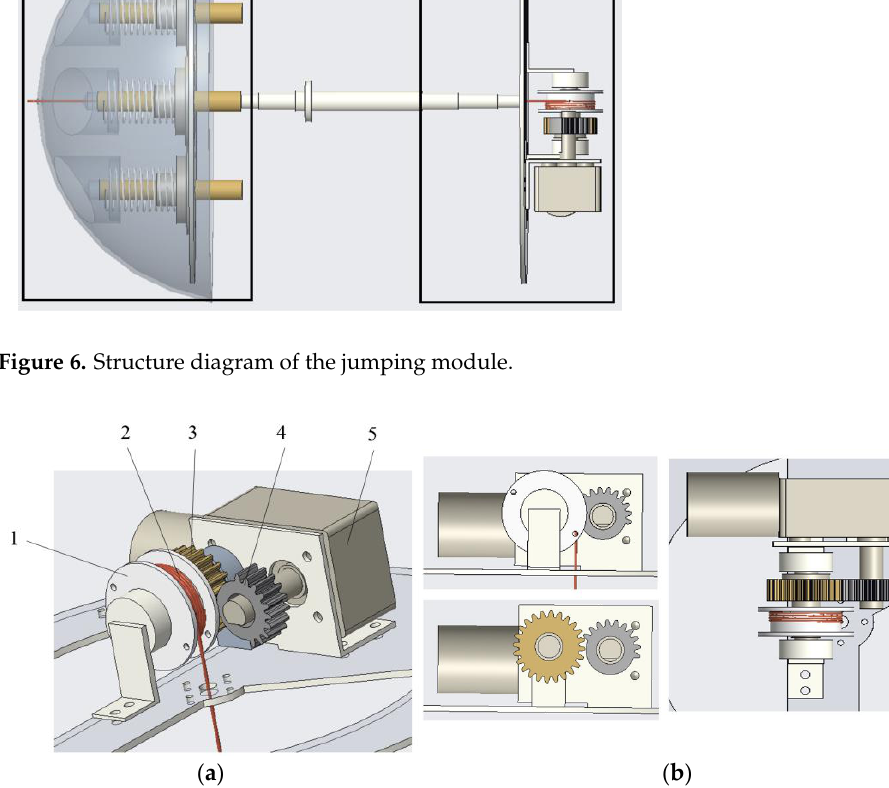
Figure 7. ( a ) Structure diagram of jumping drive, 1-roller, 2-rope, 3-gear, 4-incomplete gear, and 5-energy storage motor; ( b ) Front view and top view of the jumping drive.